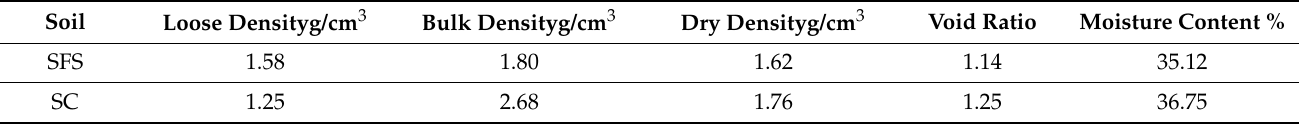
Table 1. Basic physical and mechanical parameters of the SFS and the